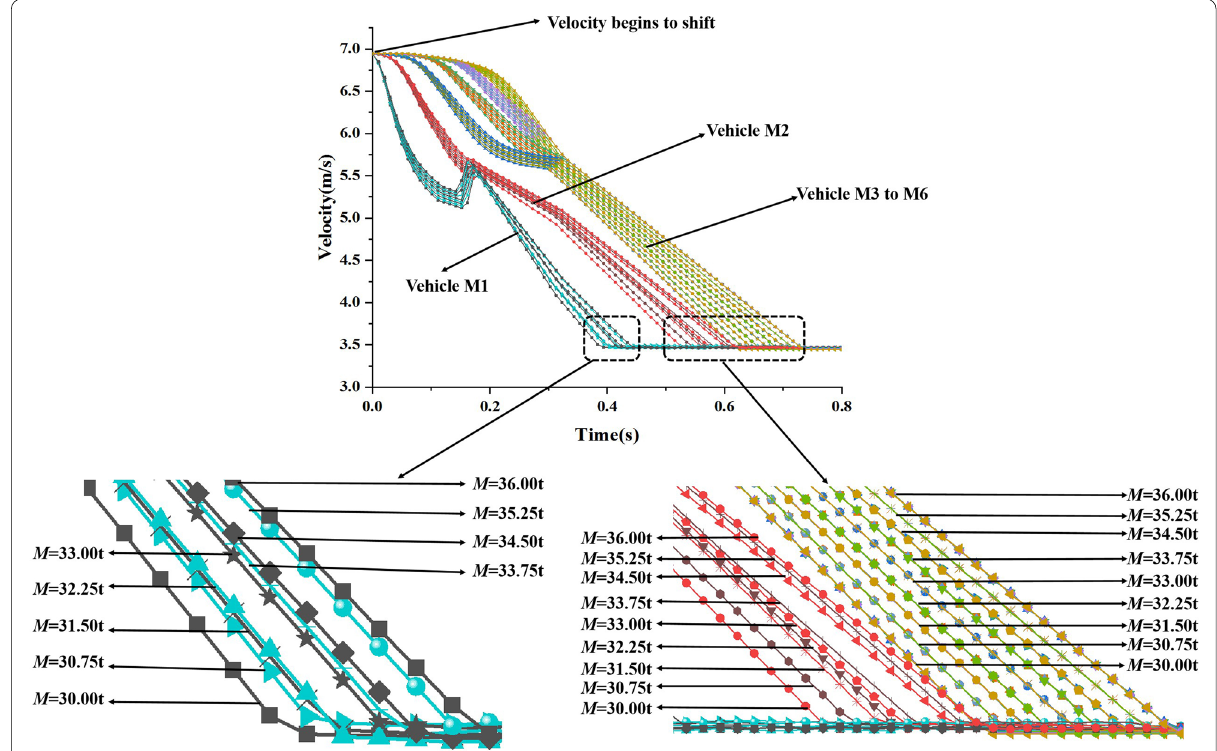
Figure 8 Velocity versus time curves of the vehicles under different